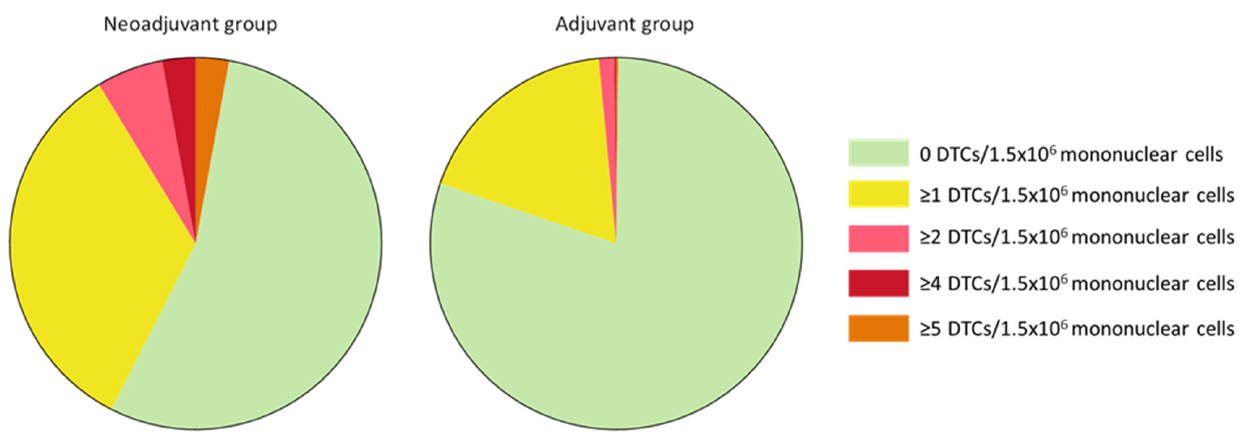
Figure A1. Univariate survival analysis by disseminated tumor cell (DTC) status before the start of adjuvant chemotherapy. Kaplan–Maier plots of ( A ) overall survival (OS) and ( B ) disease-free sur- vival (DFS) for DTC-negative (purple line) as compared to DTC-positive (blue line) treatment-naïve patients.